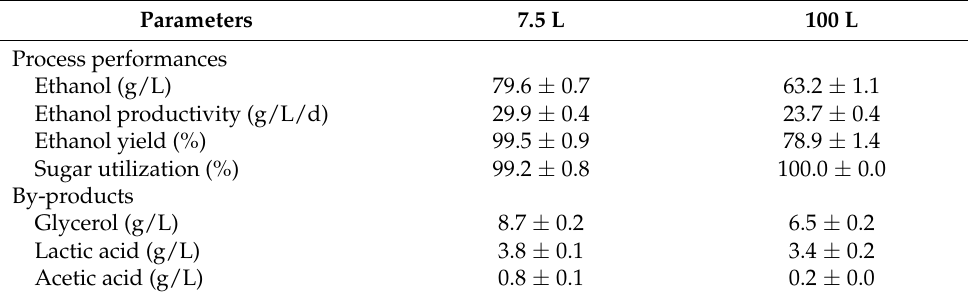
Table 5. Fermentation performances and by-products concentrations measured after 64 h of incuba- tion at 7.5 and 100 L bioreactors scale using diluted sugar beet molasses (170 g/L of initial sugar) together with 0.27 g/L of Saccharomyces cerevisiae and 4.0 g/L of nutrient. Parameters 7.5 L 100 L Process performances Ethanol (g/L)